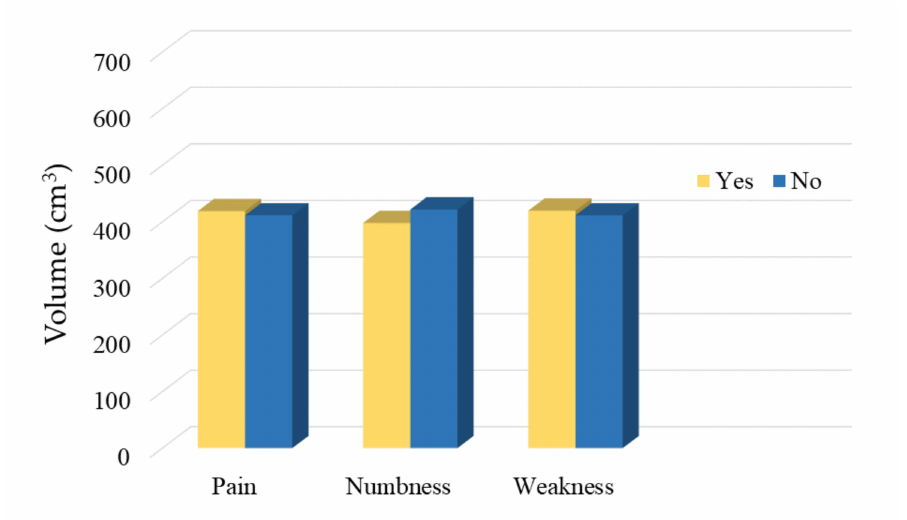
Figure 3. Comparison of psoas major muscle volume of the two